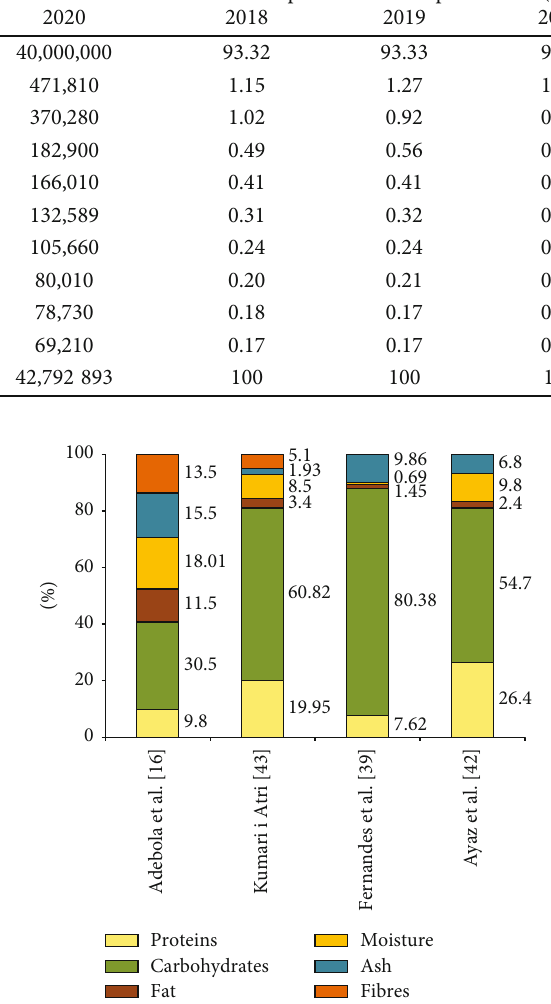
Figure 2: The percentage of the main nutrients in the fruiting bodies of Macrolepiota procera (in 100g